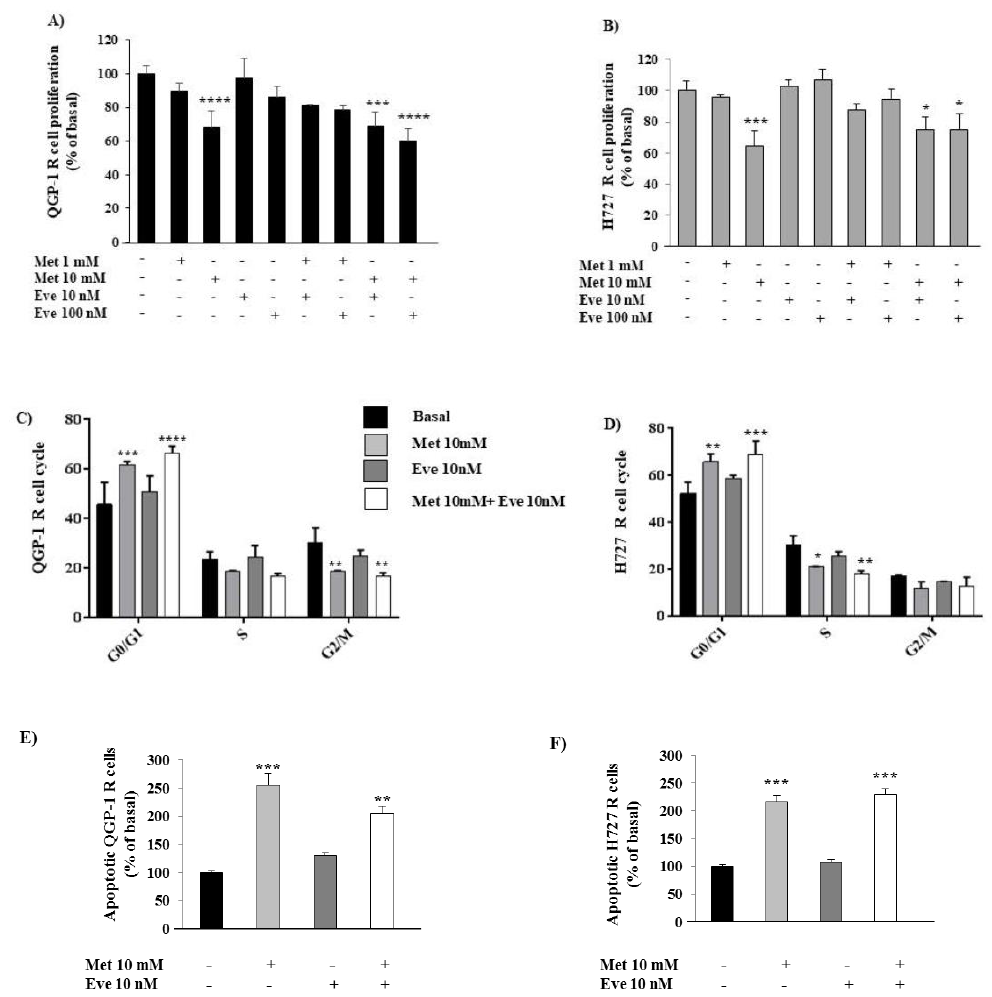
Figure 6. Metformin (Met) continued to exert its anticancer effects on cell proliferation, cell cycle and apoptosis in QGP-1-R and H727-R cells. ( A , B ) To measure cell proliferation, everolimus-resistant QGP-1-R and H727R cell were treated with metformin (1–10 mM) and everolimus (Eve 10–100 nM) or their combination for 24 h and then with BrdU for 2 h. Experiments were repeated 3 times and each determination was done in triplicate. Values represent mean (± SD.) * = p < 0.05, *** = p < 0.001, **** = p < 0.0001 vs. corresponding basal. ( C , D ) QGP-1-R and H727-R cells were treated with metformin (10 mM) and everolimus (10 nM) or their combination for 24 h and their cell cycle was analyzed by flow